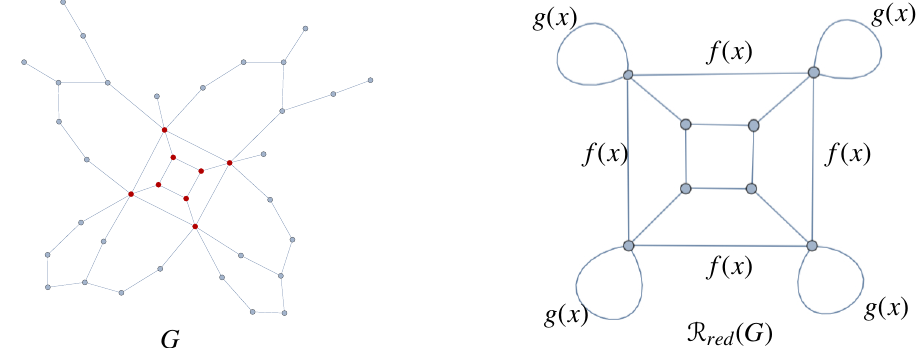
Fig. 6 The graph G (left) is isospectrally reduced over the red vertices resulting in the graph R red ( G ). The rational function weights f and g are the functions f ( x ) = x 6 − 6 x 4 + 10 x 2 − 4